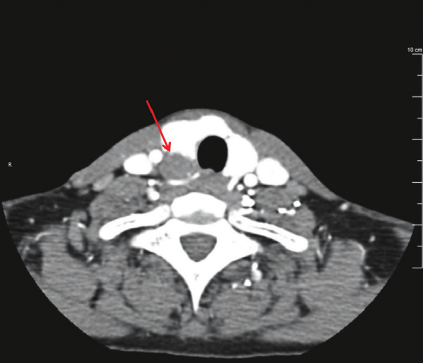
Figure 2: Axial CT-neck with contrast reveals an enlarged right inferior parathyroid gland ( red arrow )